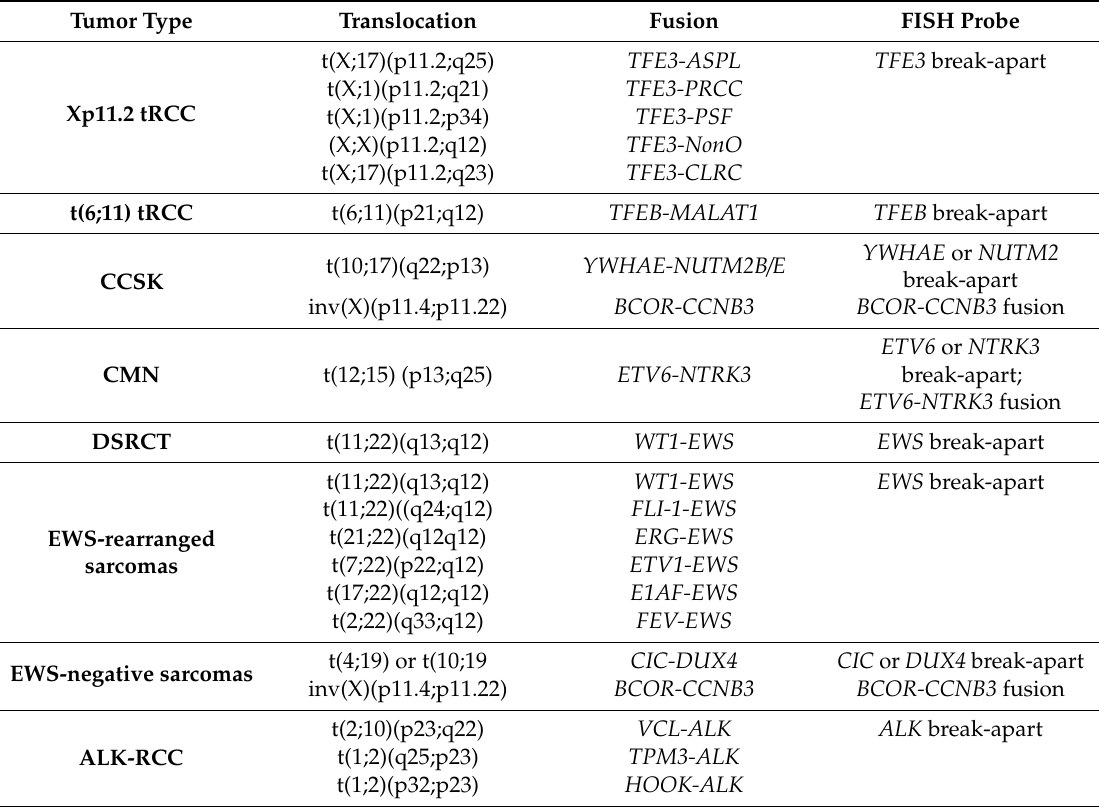
Table 7. Translocations present in the most common pediatric renal tumors which can be demonstrated by fluorescent in situ hybridization